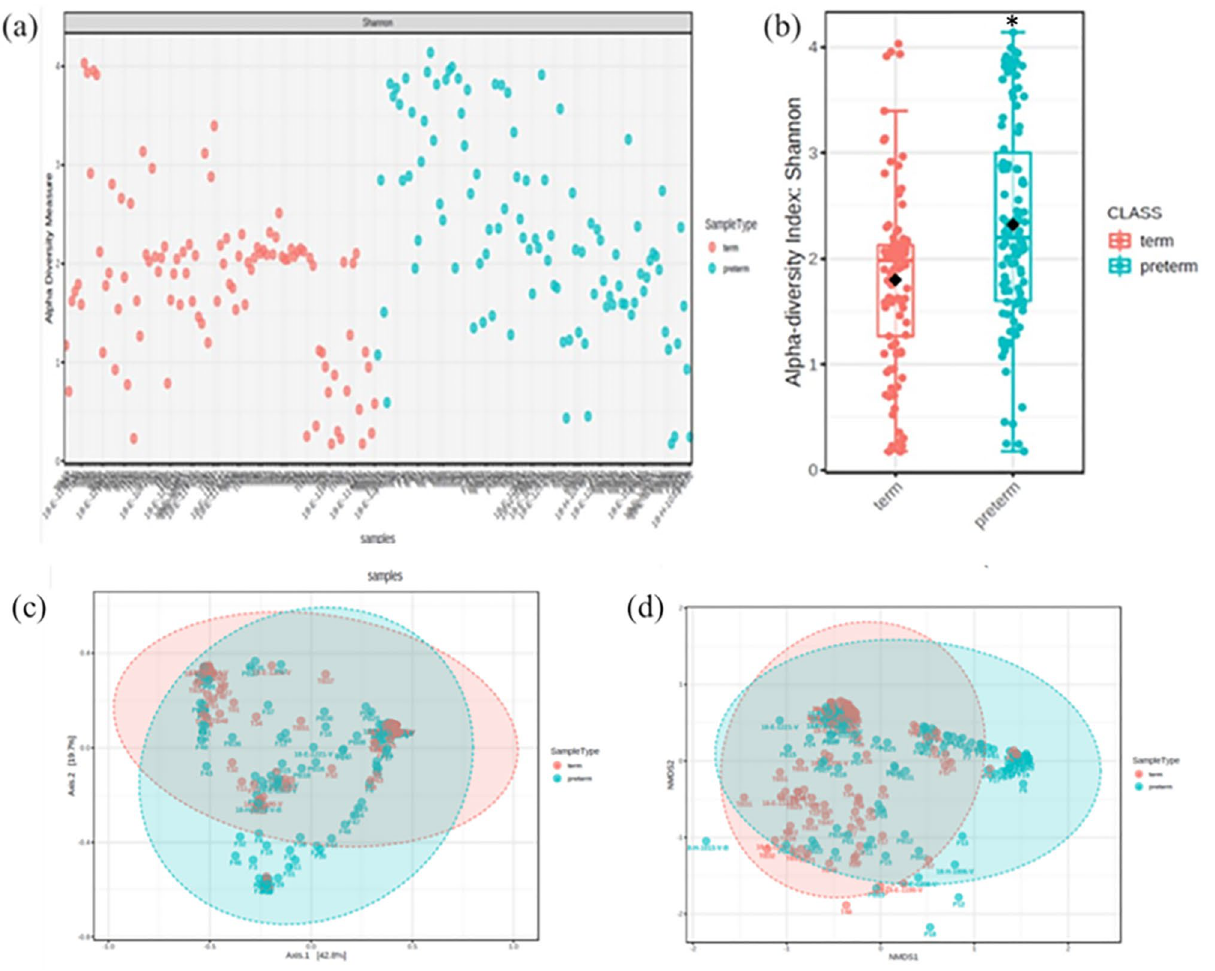
Figure 2. Differences in alpha- and beta-diversity between PTB and TB groups. ( a , b ) Shannon’s alpha diversity was significantly higher in the PTB group (PTB, n = 102; TB, n = 101). ( c ) Principal coordinate analysis plot ( d ) Non-metric multidimensional scaling plot. Boxes show median and interquartile ranges, black dots represent the average, and whiskers extend from minimum to maximum values. The asterisk symbol shows a significant difference. *Statistical significance was defined as P <